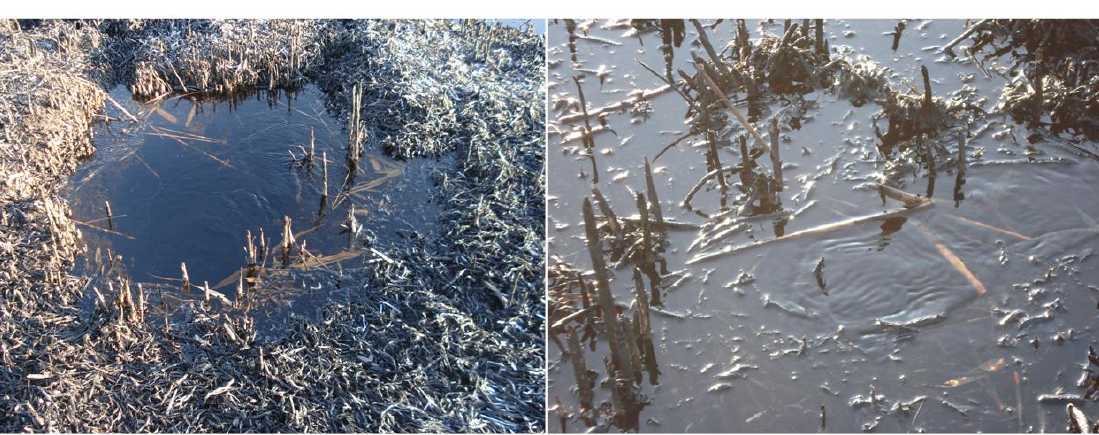
Figure 5. Examples for subaquatic springs detected in the upper part of the Gerhard Minnebron wetland in close proximity to the